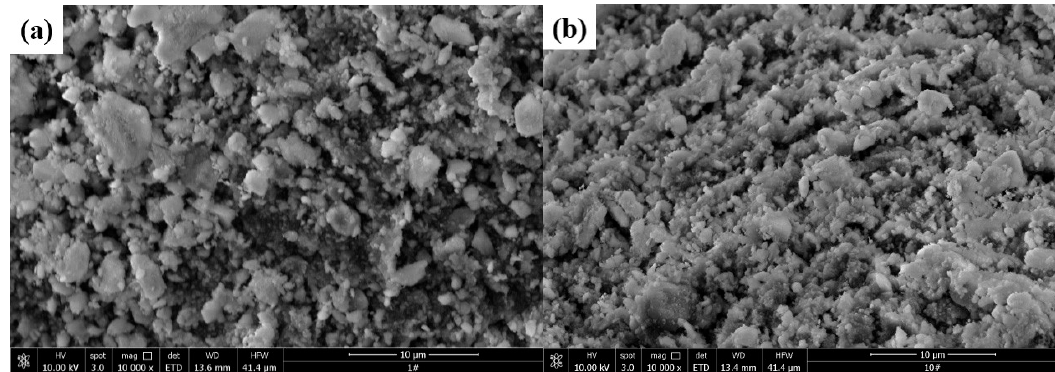
Figure 12. Morphology analysis of Al 2 O 3 ( a ) and SrO-Al 2 O 3 ( b )